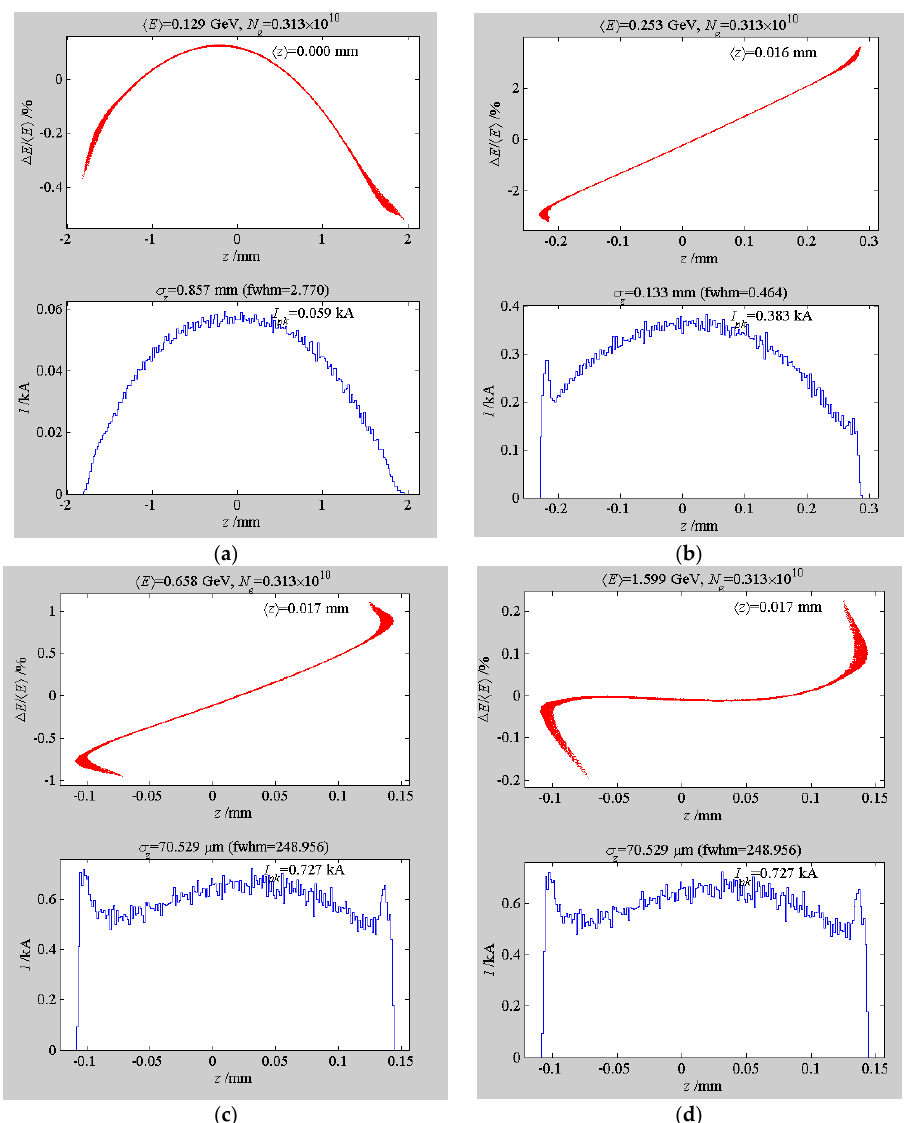
Figure 13. Simulation results of the electron beam distributions: energy distributions and current profiles at ( a ) injector exit; ( b ) BC1 exit; ( c ) BC2 exit and ( d ) L3